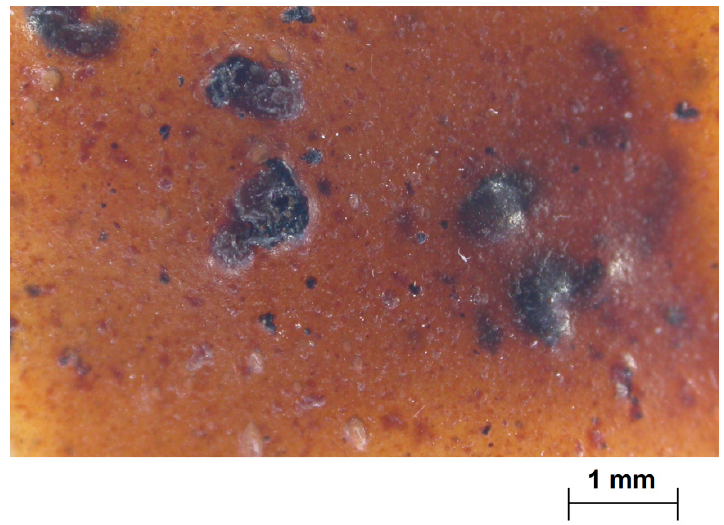
Figure 3. Macrograph of the material with fragments of leather waste.